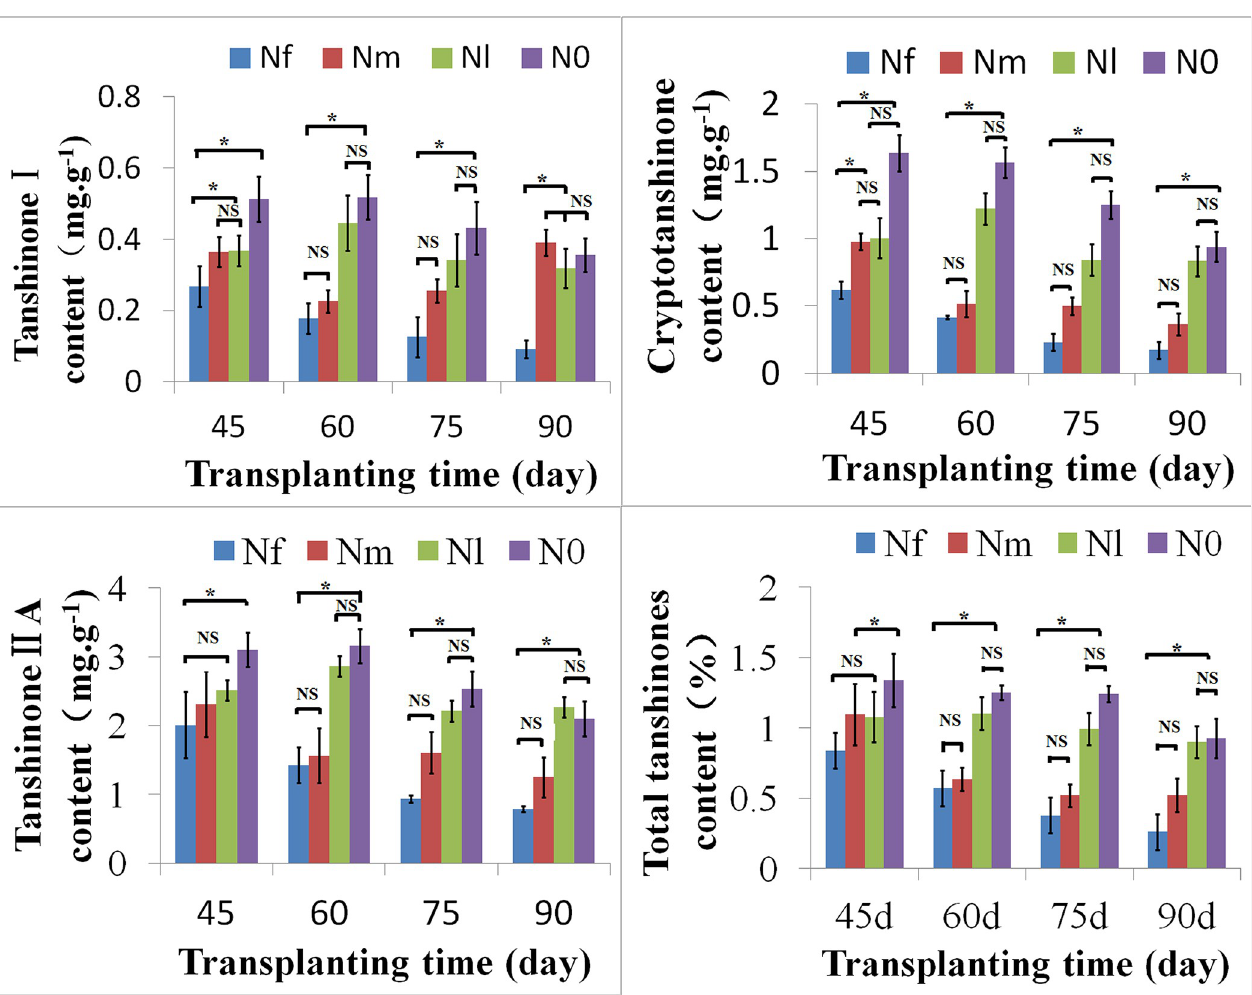
Fig 3. Low nitrogen influencing on the tanshinones in roots of S . miltiorrhiza at 45, 60, 75, and 90 days after transplanting (DAT), respectively. Values are as means ± SD, n = 5. Asterisks represented significant differences between treatments, NS indicate no significant differences (Student’s t -test, P < 0.05).